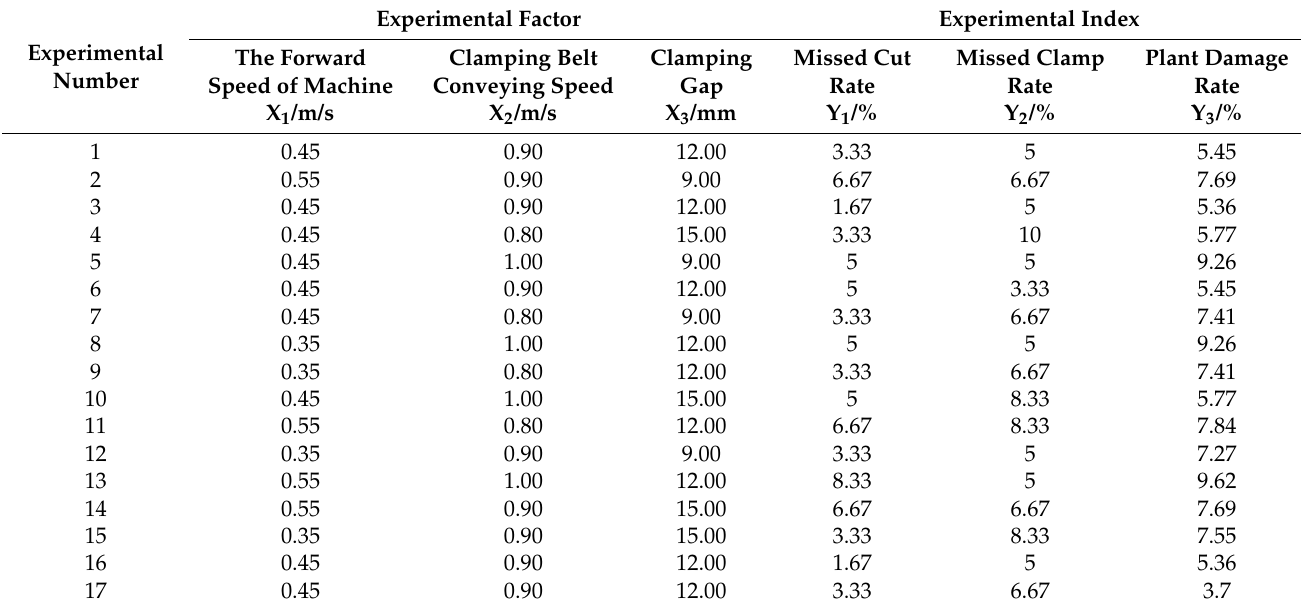
Table 5. Experimental scheme and